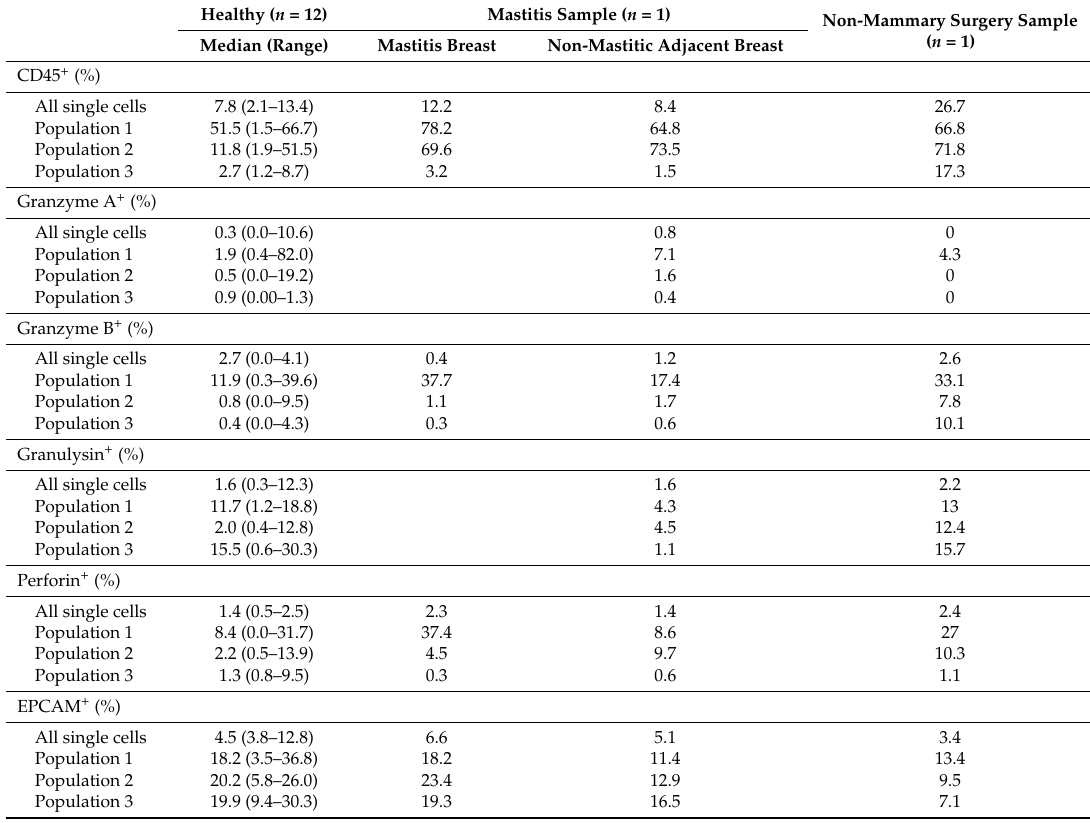
Table 2. Flow cytometric analysis of immune and epithelial cell proteins in HM cells (%) taken from healthy, mastitis and non-mammary post-surgery participants. Single marker expression. Healthy ( n = 12) Mastitis Sample ( n = 1) Non-Mammary Surgery Sample